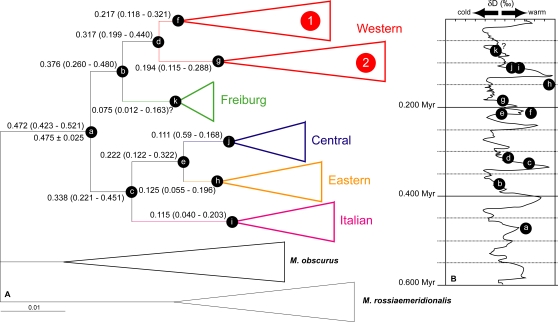
Divergence time estimates within and among Microtus arvalis lineages.Numbers at nodes (b to k) of the simplified Bayesian tree (A) are times to most recent common ancestors (with 95% confidence) estimated from cytochrome b gene sequences with BEAST. Numbers at node (a) are the divergence time estimate by BEAST (above branch) based on the fossil calibration point (below branch; Miesenheim I, Germany) [29], [30]. Small letters allow one to locate the possible lineage appearance on the δD curve (B) from EPICA Dome C (modified from [75]).